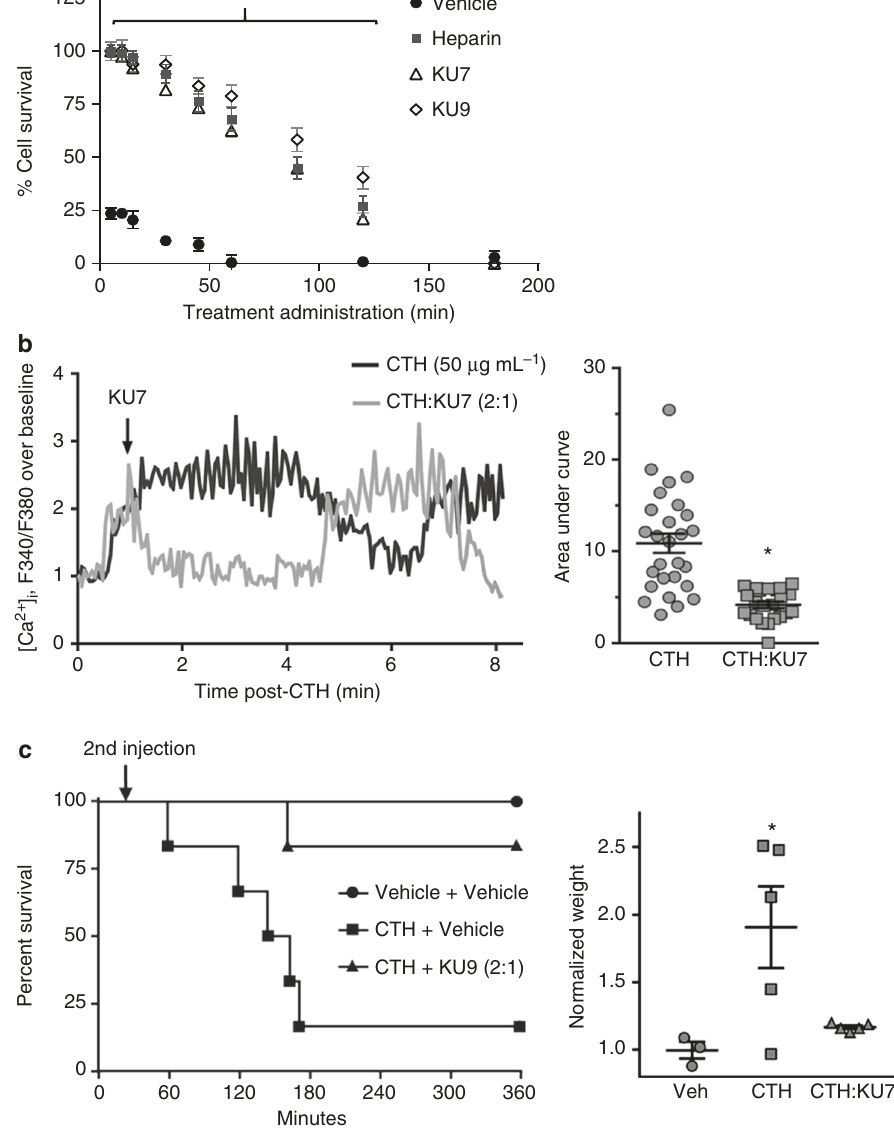
Fig. 5 Ef fi cacy of anti-histone aptamers when administered after histones. a Aptamer inhibition of histone-mediated cytotoxicity of endothelial cells determined by MTS assay. EA.hy926 cells treated with 200 µ g mL − 1 of calf thymus histones followed by administration of either vehicle (negative control), heparin (positive control, 1:1), KU7 aptamer (1:2) or KU9 aptamer (1:2) at time points of 0, 5, 10, 15, 30, 45, 60, 90, 120 and 180 min after CTH; n = 3 biological replicates; * p < 0.0025 vs. vehicle. b Dynamic changes of intracellular calcium levels in Fura 2-AM-loaded EA.hy926 cells using fl